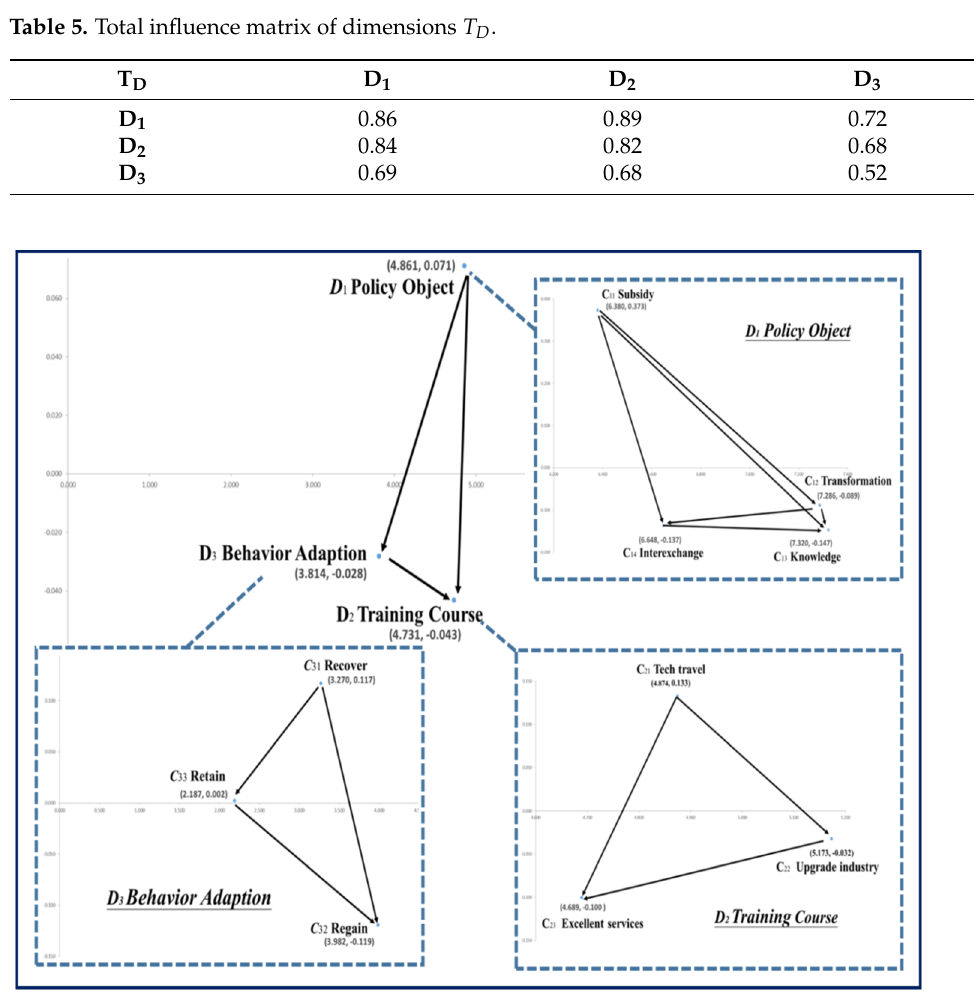
Figure 2. INRM (influential network relation map) of paid training measure.